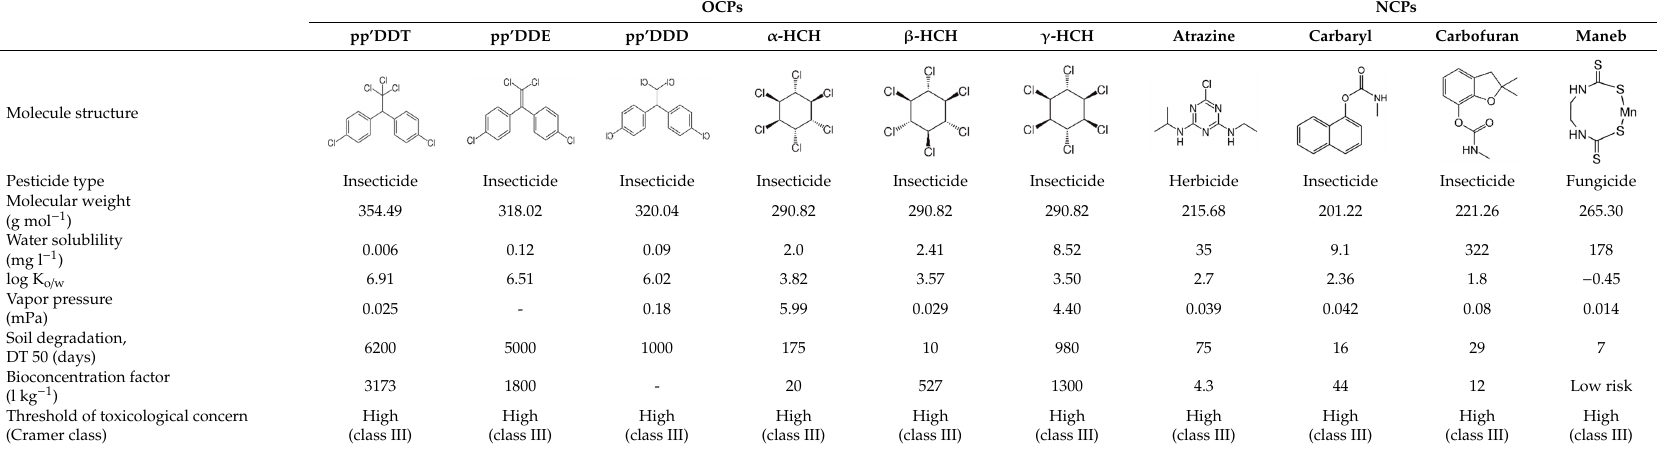
Table 3. Chemical and physical properties nonchlorinated-pesticide compounds (NCPs) and chlorinated-pesticide compounds (OCPs) *.